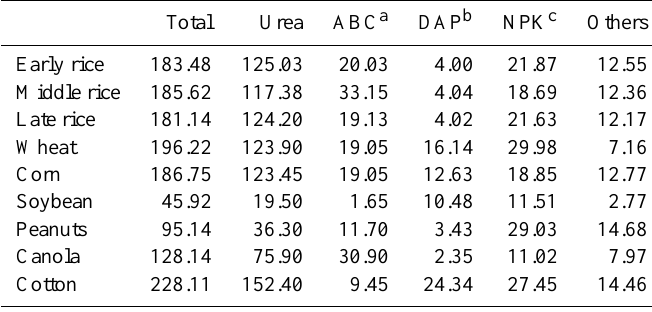
Table 2. Ratio of basal and topdressing fertilizer for major crops in each agriculture region. Region Wheat Corn Rice basal topdressing basal topdressing basal topdressing The northeast region 1.00